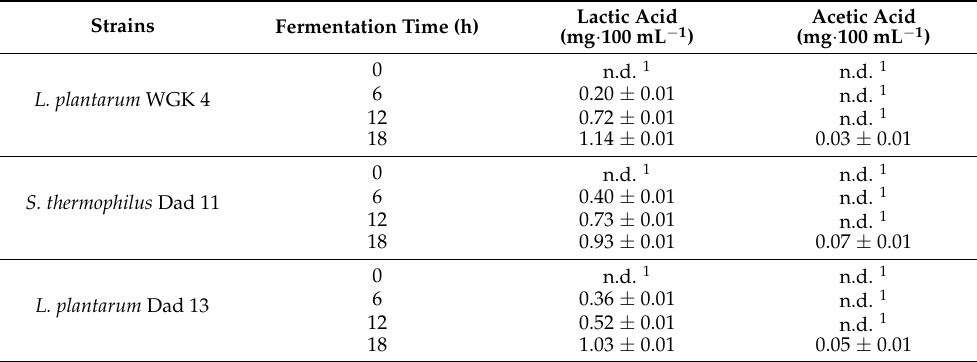
Table 4. Lactic and acetic acid of black soy milk during fermentation by Indonesian indigenous LAB (24 h, 37 ◦ C).